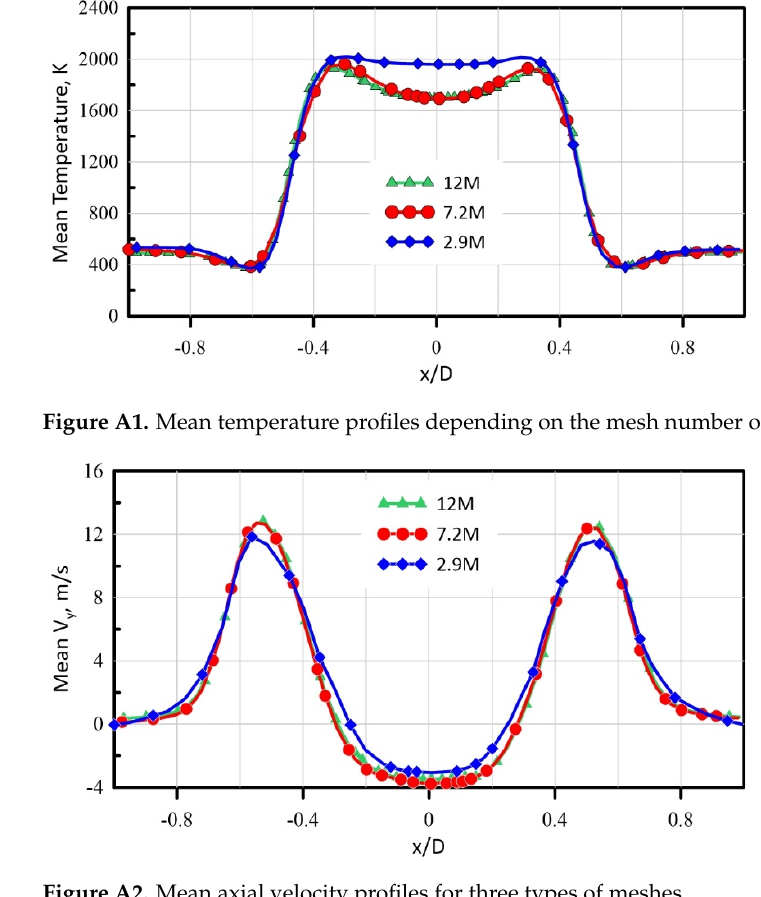
Figure A2. Mean axial velocity profiles for three types of meshes.